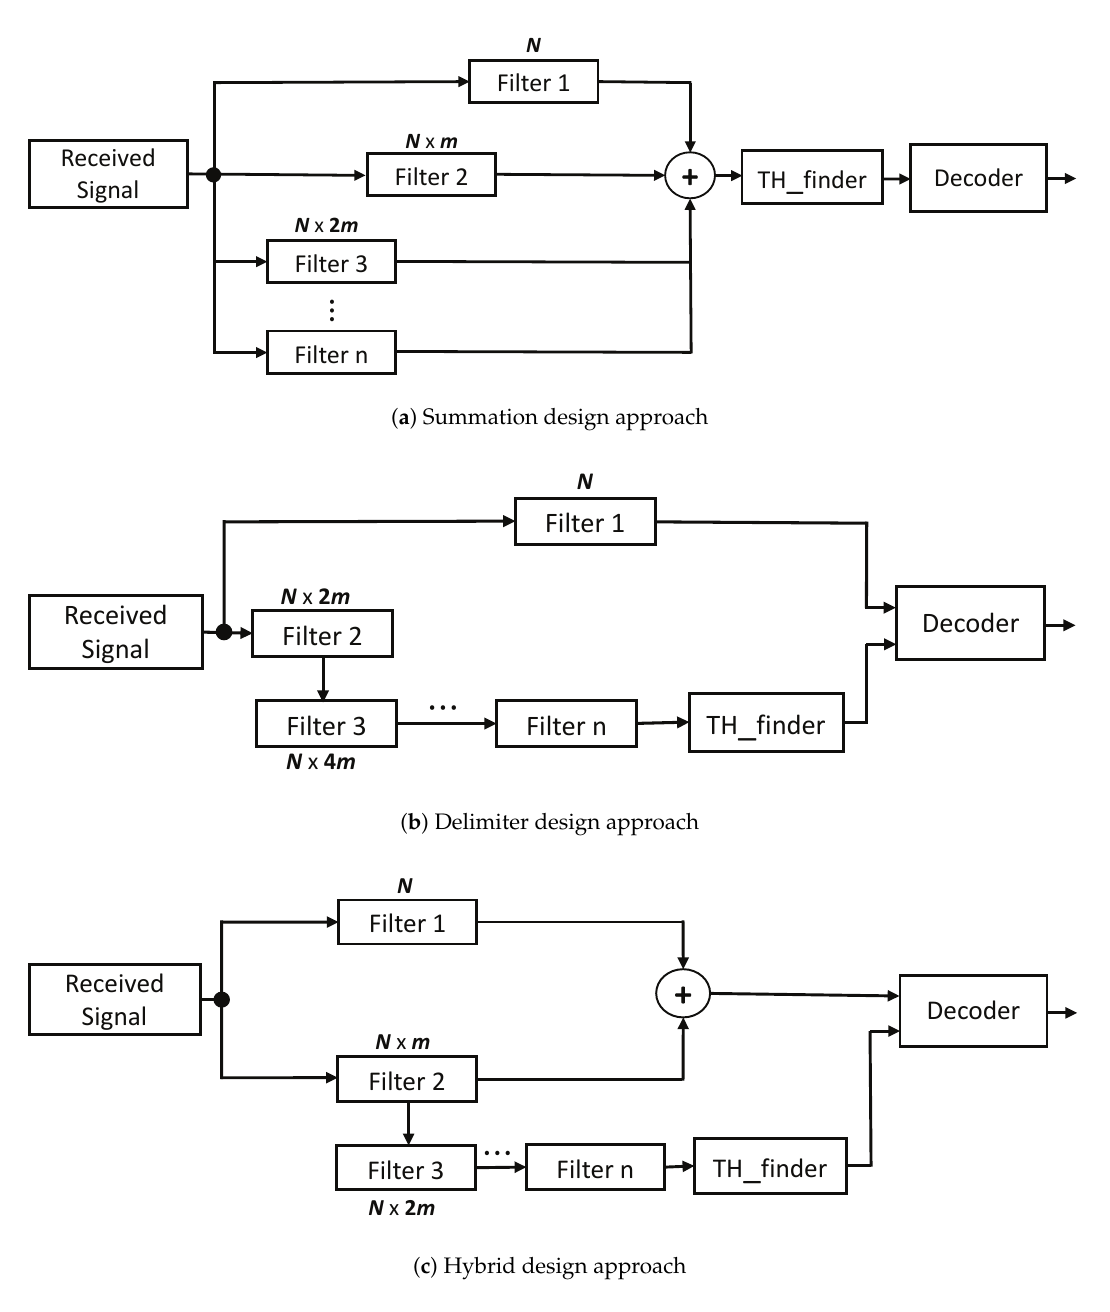
Figure 5. Proposed architecture of the multi-filter